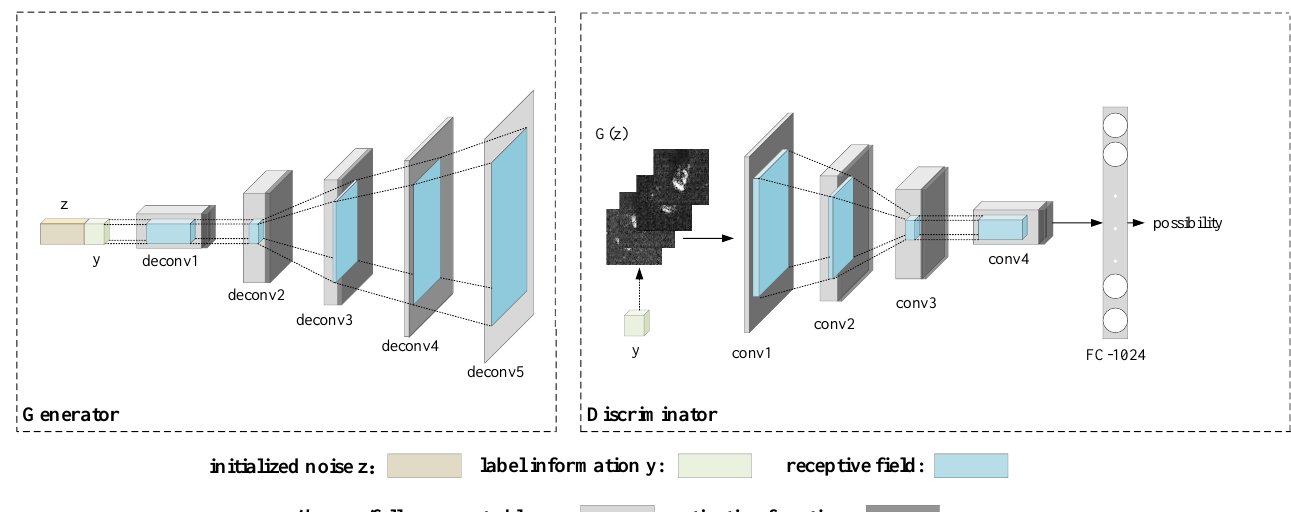
Figure 3. The architecture overview of the proposed generation model. The generation model consists of a deconvolution network and a convolution network. The condition information y refers to the target label condition. z means the initializa- tion noise when the deconvolution network is initialized. G ( z ) indicates the generated counterfactual target